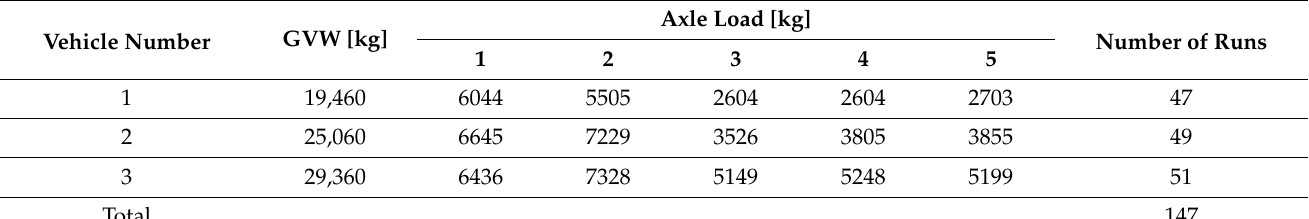
Table 1. Parameters of test vehicles used in the calibration process.